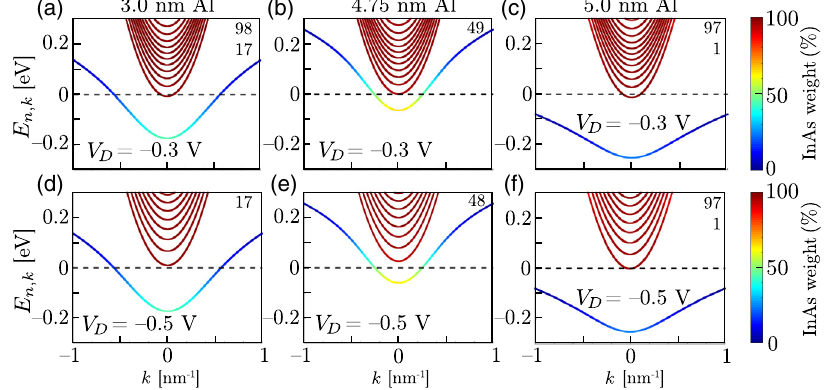
FIG. 3. (a) – (f) Band structure dependence on Al thickness and V indicates changing V . The semiconductor weights at the Fermi level of crossing bands are displayed in the top right-hand corner of D each